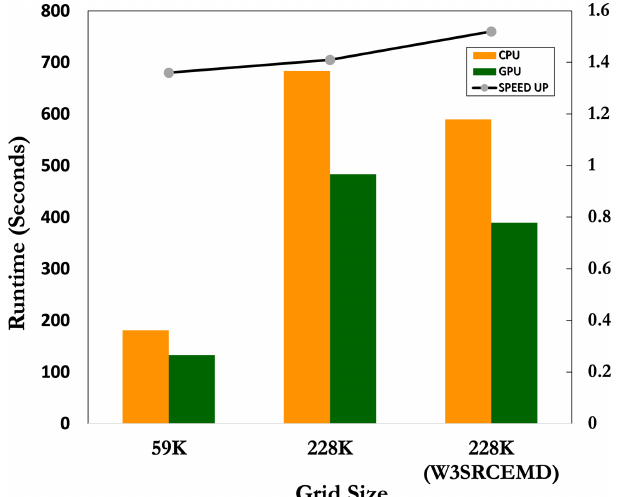
Figure 6. The runtime of WW3.cpu (orange) and WW3- W3SRCEMD.gpu (green) for 42CPU cores and 7 MPI ranks per GPU on a Summit node with 59K and 228K meshes. The right-hand bar chart shows the runtimes for only the GPU-accelerated subrou- tine, W3SRCEMD , on a 228K grid size. The black line represents the speedup of WW3-W3SRCEMD.gpu over